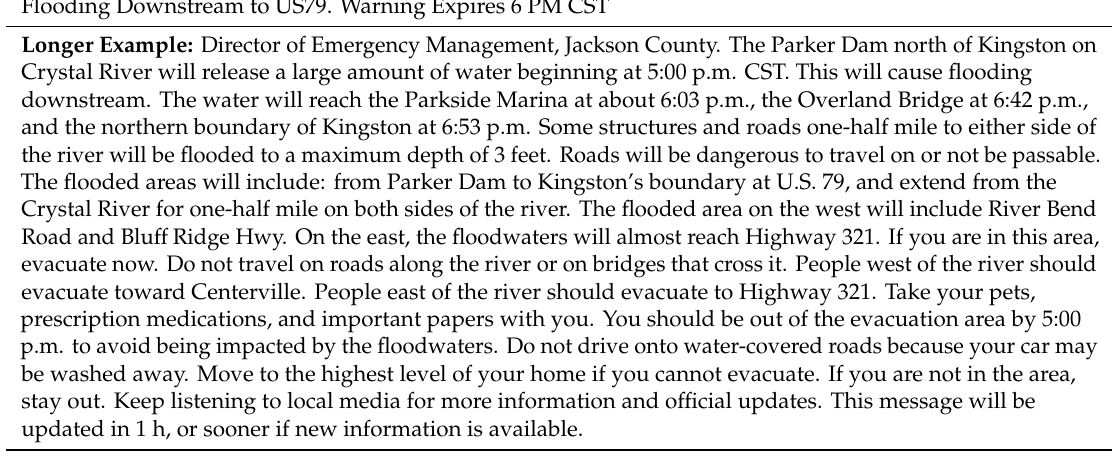
Table 8. Example messages for controlled dam release (Mileti and Sorensen, 2015